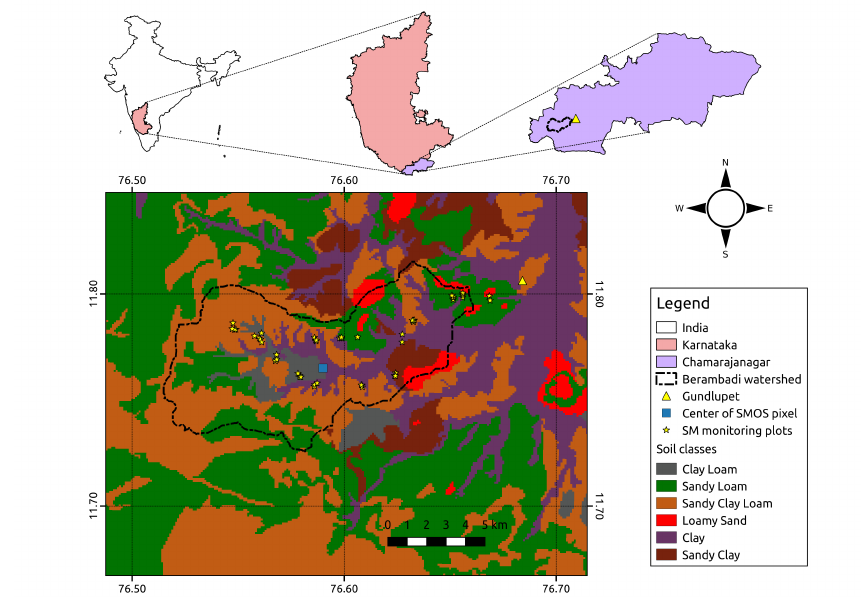
Figure 1. Soil map of the study area near Gundlupet city along with the position of the soil moisture (SM) monitoring plots, the center of the SMOS grid point and the boundary of the Berambadi